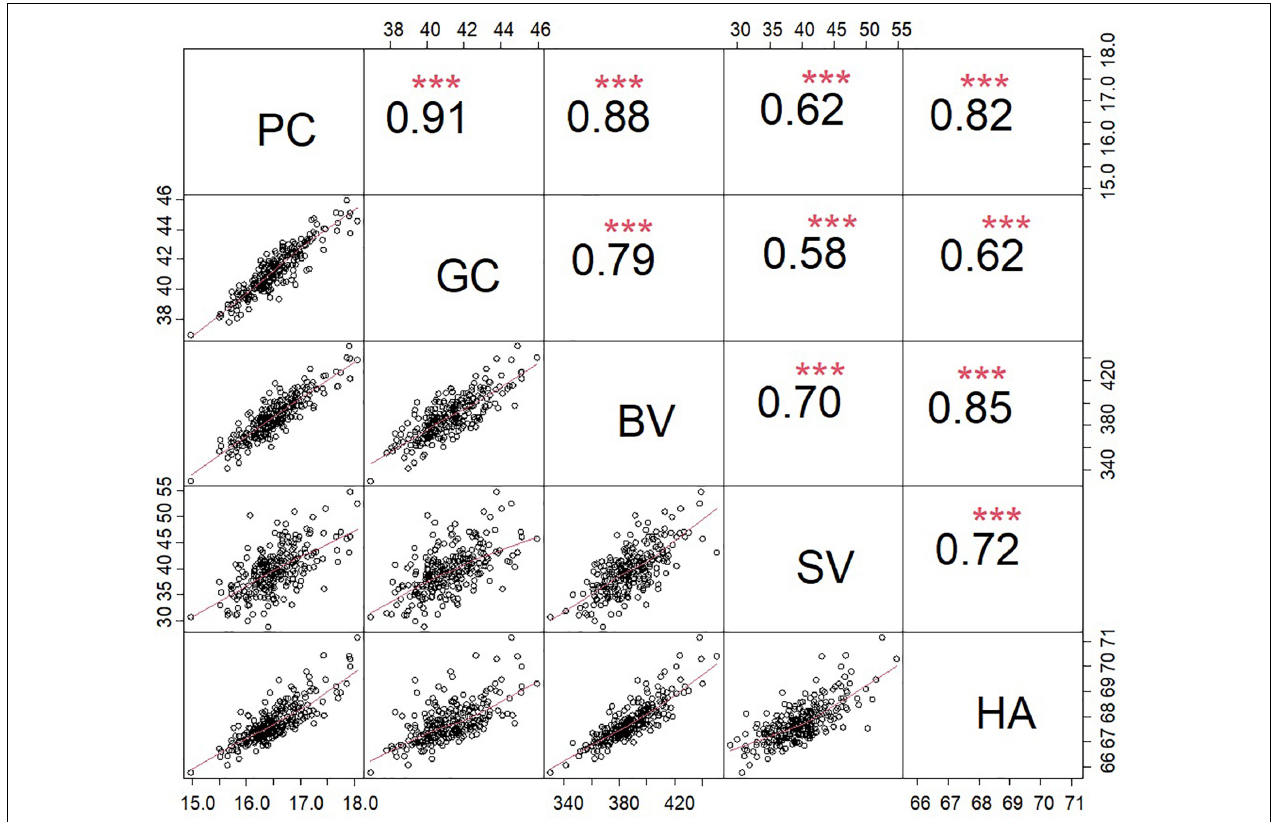
FIGURE 2 | Correlations among five quality traits. ***Represents significance at 0.001